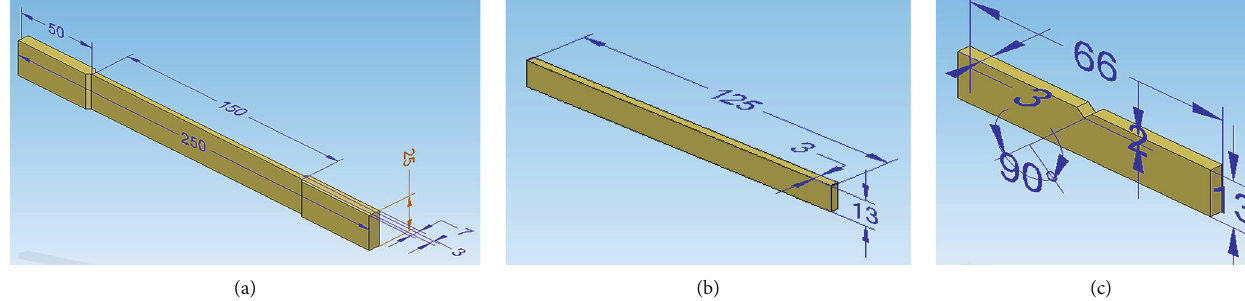
Figure 2: (a) 3D model of a tensile test specimen as per the ASTM D638 standards. (b) 3D model of the Flexural test specimen as per the ASTM D790 standards. (c) 3D model of the Charpy impact test specimen as per the ASTM D256 standards. Table 2: Density and volume fraction of